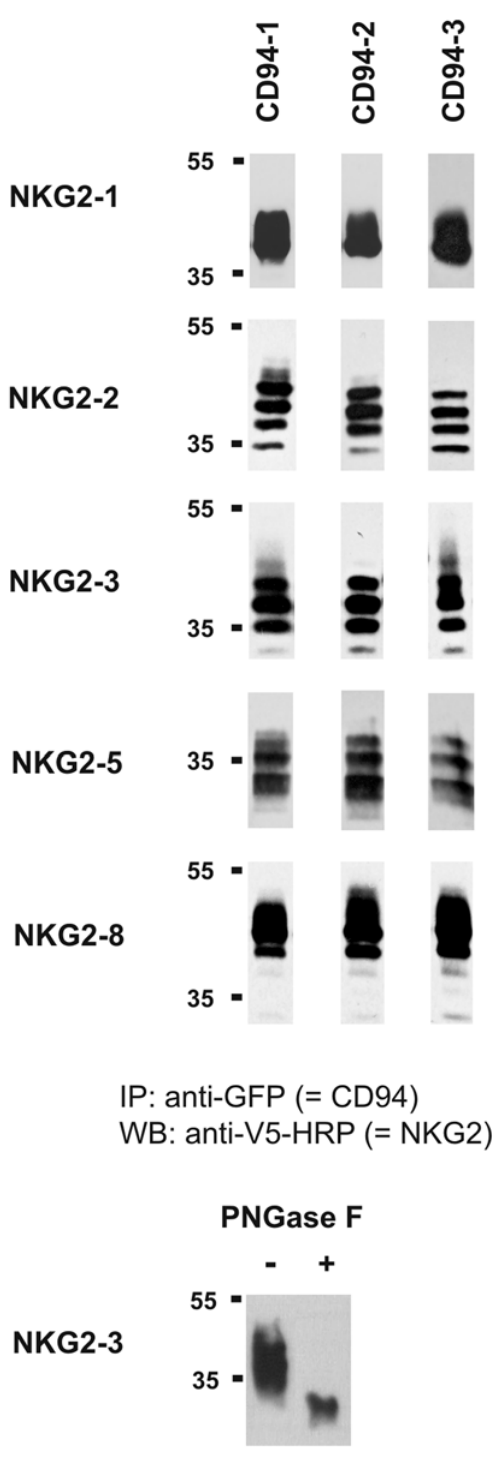
Figure 6. Co-immunoprecipitation of various combinations of grey mouse lemur CD94 and NKG2 expression constructs. CD94 constructs fused at the NH2 terminus with GFP and NKG2 molecules tagged at the COOH terminus with the V5 tag were transiently transfected into 293T cells. Analyses were performed 24h upon transfection. Representatives of at least three independent experiments are shown. Differential degree of glycosylation gives rise to multiple bands. In the lower panel deglycosylation with PNGase F is demonstrated exemplarily for inhibitory receptor NKG2-3.